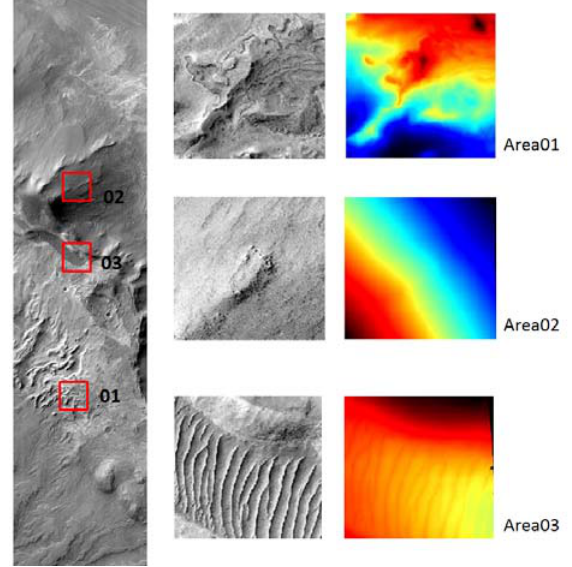
Figure 1 – Left: the Hirise image with the three patches processed; right: an enlargement of each patch and a colour coded image of the